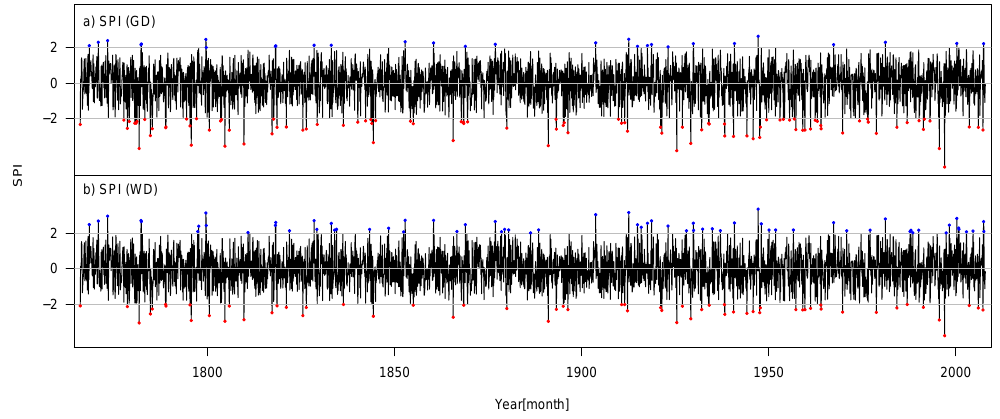
BD Fig. 2. Akaike differences (AICD) yielded by the Gamma (GD), Weibull (WD), Burr Type III, (BD), exponen-